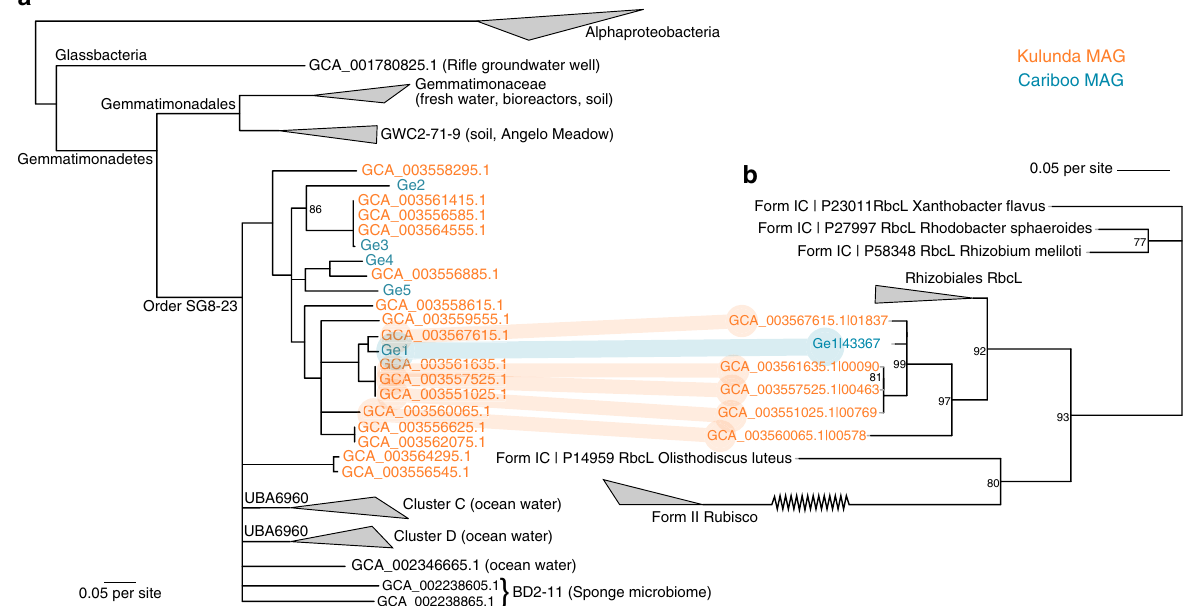
Fig. 5 Lateral gene transfer of RuBisCO into Gemmatimonadetes phototrophs. a Maximum likelihood phylogenetic tree of 19 concatenated ribosomal and RNA polymerase genes obtained from Gemmatimonadota MAGs available in public databases, as well as fi ve MAGs obtained from Cariboo lakes (blue, Ge1 – Ge5) and sixteen from Kulunda lakes (orange). Soda lake MAGs form two clusters within GTDB order SG8-23, which further contains several clusters previously recovered from marine habitats. b Maximum likelihood phylogenetic tree of RuBisCO Form 1 encoded on MAGs in one of the Gemmatimonadota clusters. The congruence between the two trees indicates vertical inheritance after a single horizontal gene transfer event from Alphaproteobacteria. Nodes with <75% bootstrap support were collapsed into multifurcations. For remaining nodes, bootstrap values were 100% unless indicated otherwise. Supplementary Tables 3 and 4 contain the list of reference sequences used for Fig. 5a,